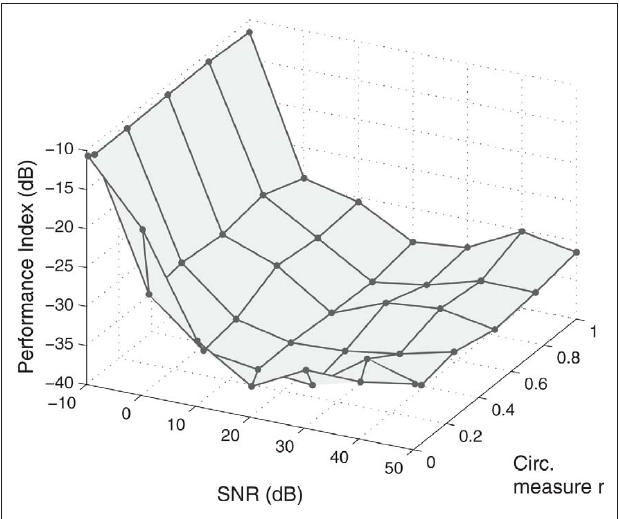
FiGurE 9 | Placement of the EEG electrodes on the scalp according to the recording 10–20 system.